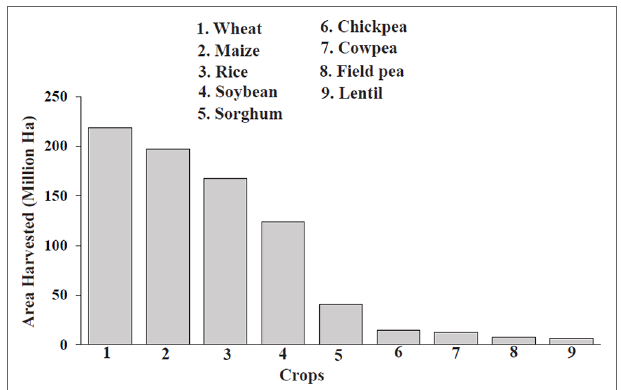
FIGURE 1 | Comparison of area harvested for cereals and field pea in 2017 (FAOSTAT, 2019). The numbers above each bar represent the individual harvest totals of each